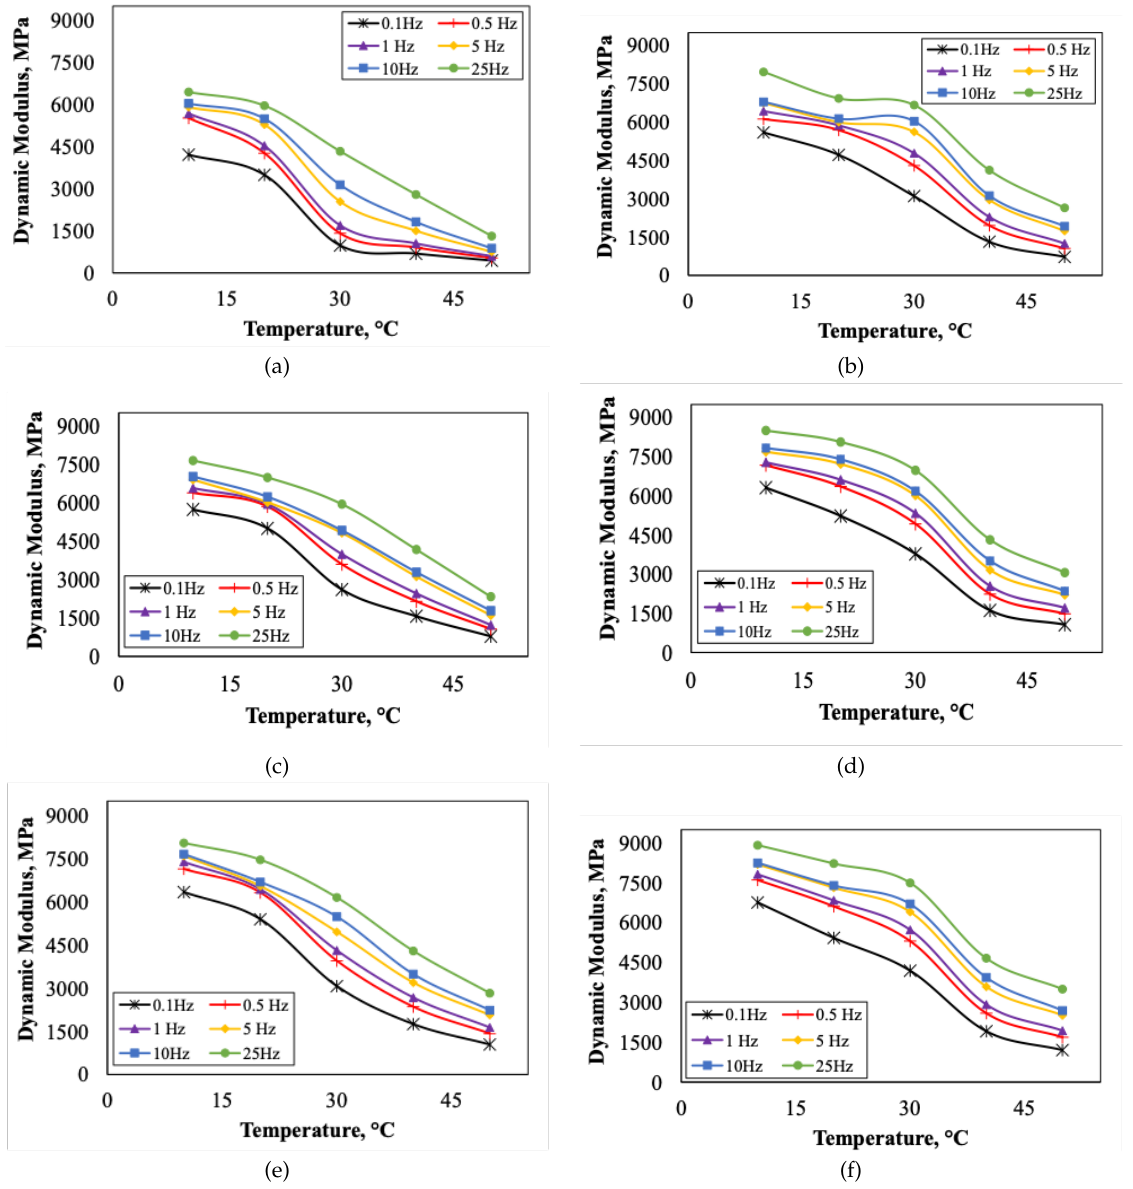
Fig. 4. Experimental results of dynamic modulus of mixtures: (a) Virgin mixture - STOA; (b) Virgin mixture – LTOA; (c) PMB mixture – STOA; (d) PMB mixture – LTOA; (e) rPE mixture – STOA; (f) rPE mixture –